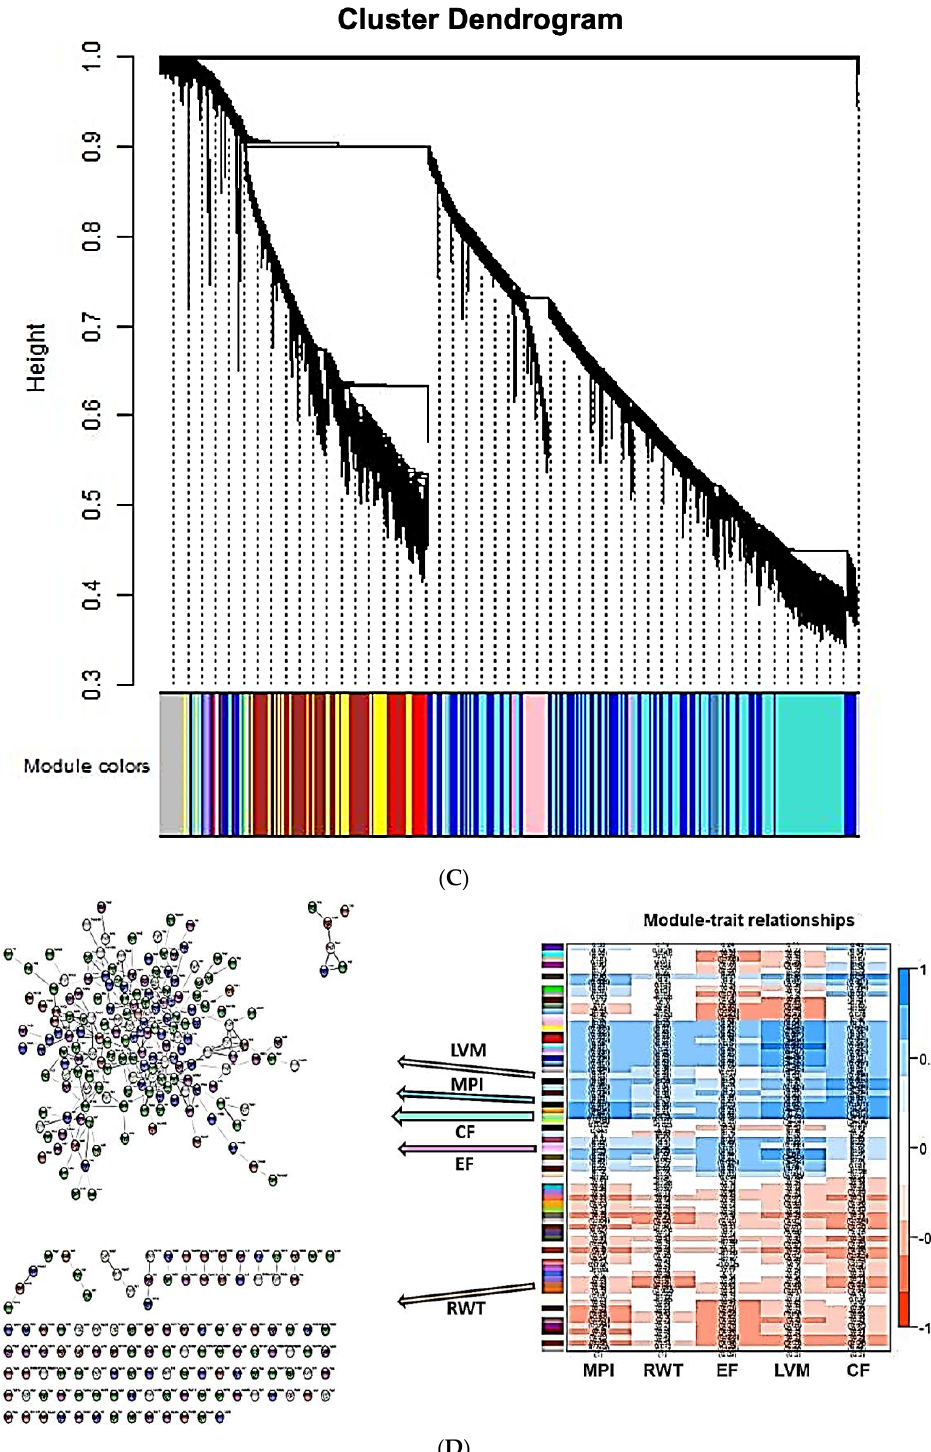
Figure 2. ( A ) Network dendrogram and trait heat map. Hierarchical clustering of treatment groups that summarize the modules found in the clustering analysis. Branches of the dendrogram cluster together into treatment groups that are positively correlated. Heat map displays correlation between di ff erent parameters analyzed. ( B ) Scale independence and mean connectivity as a function of soft threshold in PNx model. Based on these data, we chose a soft threshold (power) of 20 to construct the network(s) described in subsequent figures. ( C ) Dendrogram and group assignments produced